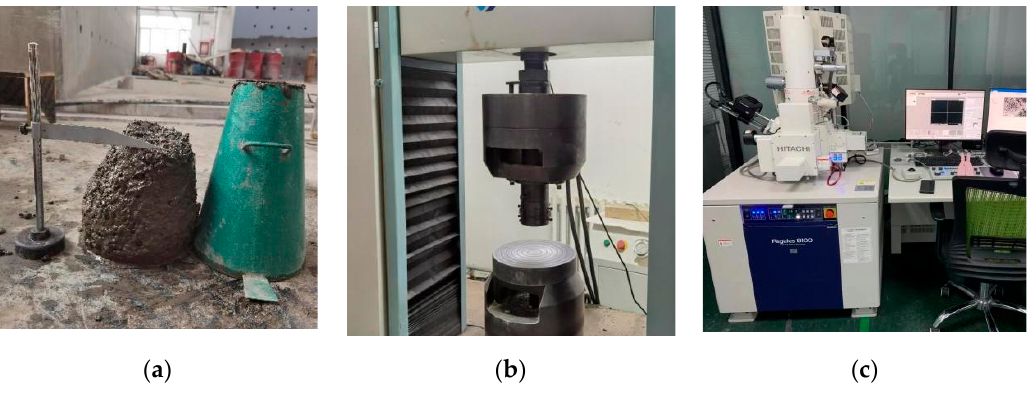
Figure 4. The test devices: ( a ) slump; ( b ) compressive strength; ( c ) SEM.